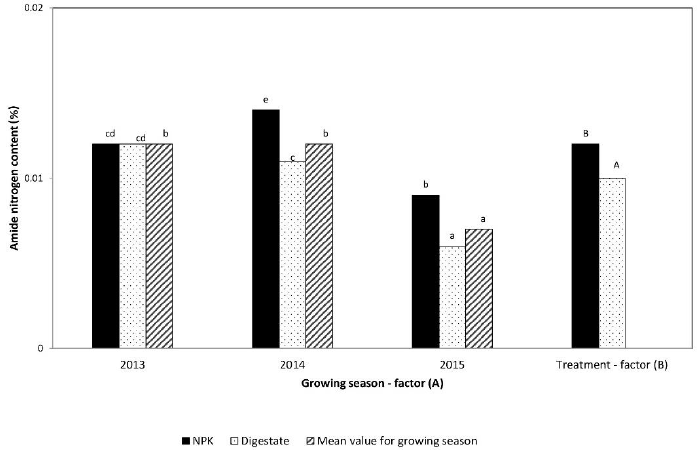
Figure 9. Effects of growing seasons and fertilization treatments on content of amide nitrogen in sugar beet roots.